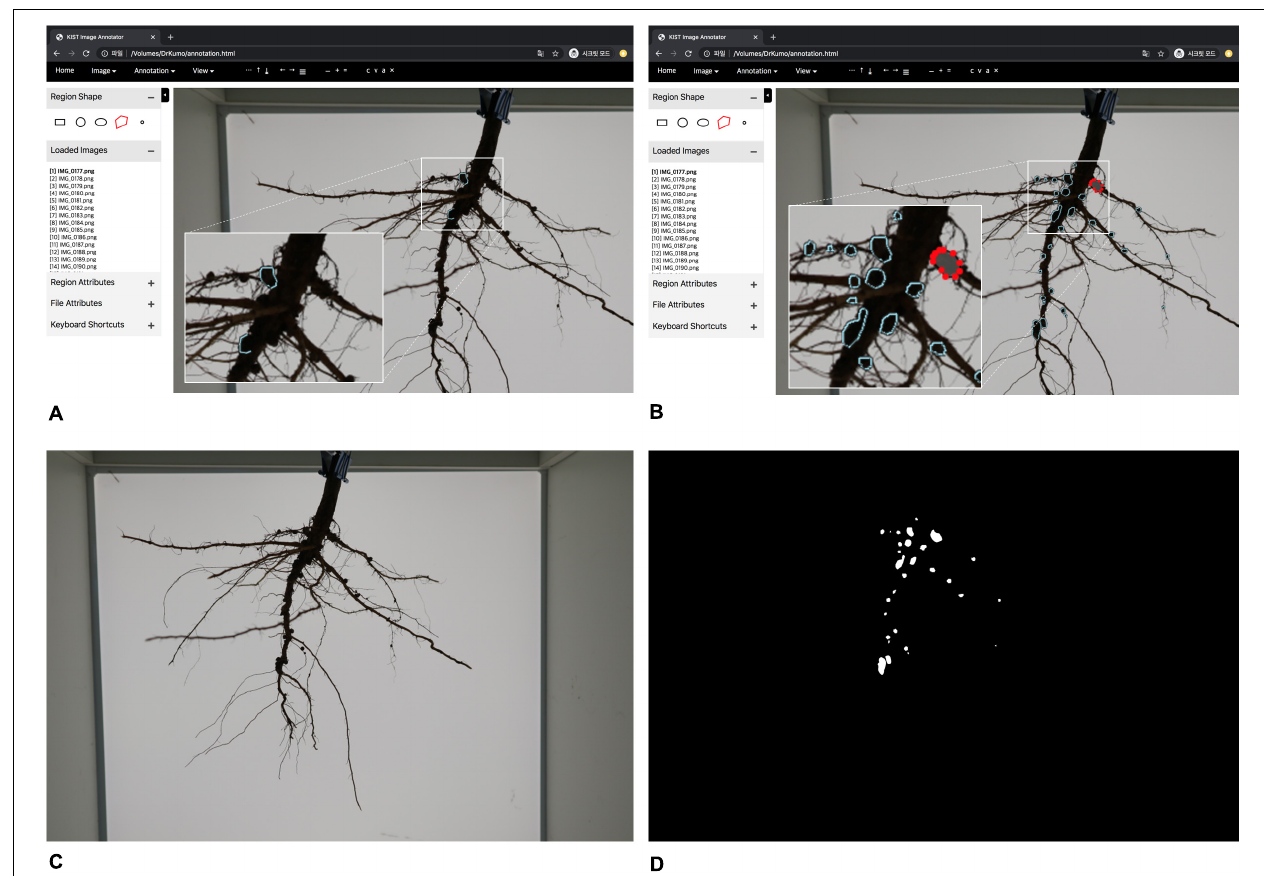
FIGURE 3 | Graphical User Interface of annotation tool and training data generation. (A) overview of annotation tool (B) manual inputs of annotation by clicking polygons (C) an RGB color image (D) a mask